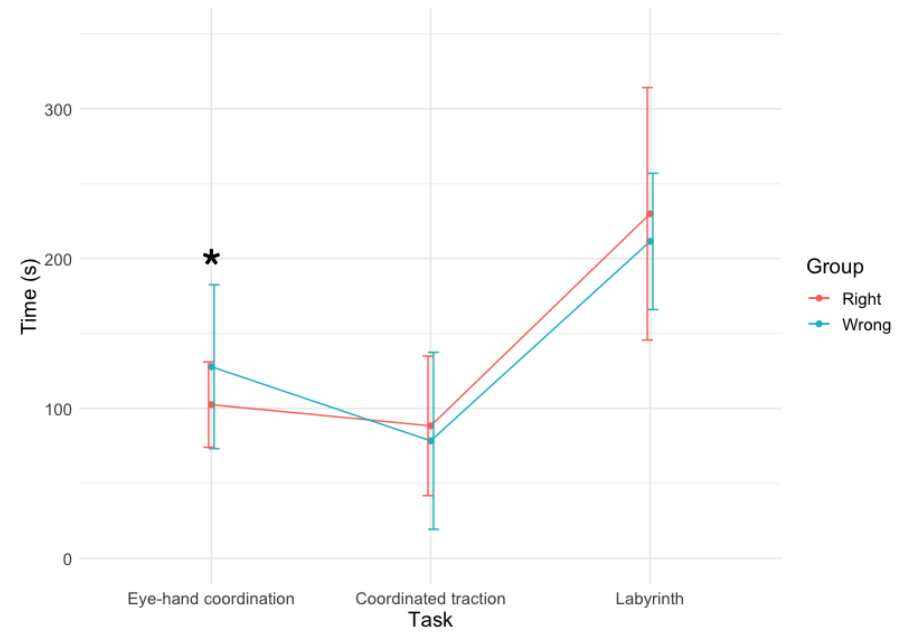
Figure 5. Execution time of the three laparoscopic tasks using the right and wrong instrument handle size. * p < 0.05.